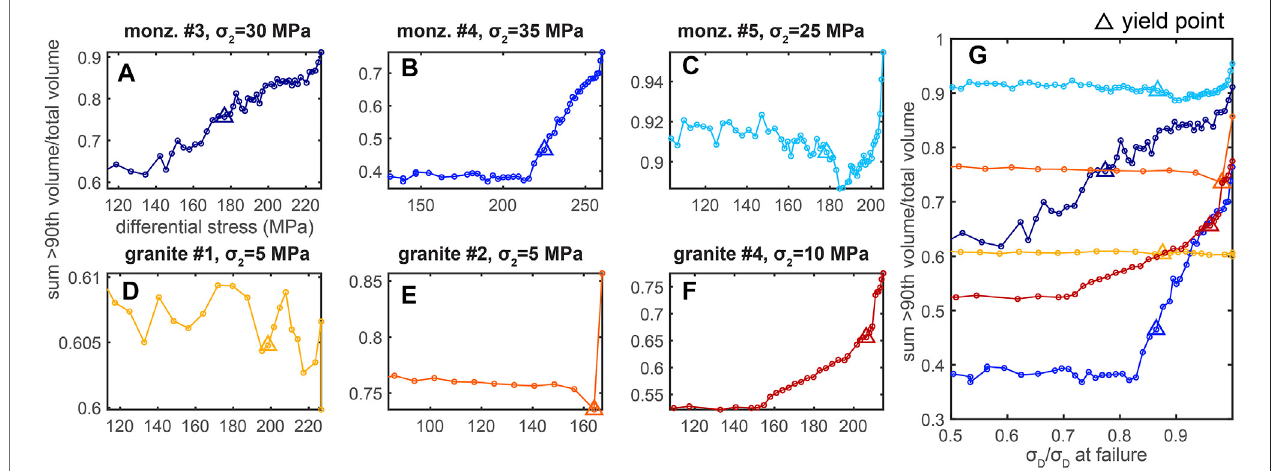
FIGURE5| Evolutionofthesum ofthe fracture volumes withvalues > 90thpercentile divided bythetotal volume offractures, (cid:1) v 90 / v tot , throughout each individual experiment (A – F) , and for all the experiments (G) . Color of the lines in (G) matches the colors of each experiment shown in (A – F) . Triangles show the conditions of the yield point. Increasing (cid:1) v 90 / v tot indicates increasing localization toward the largest fractures in the network, with volumes > 90th percentile.